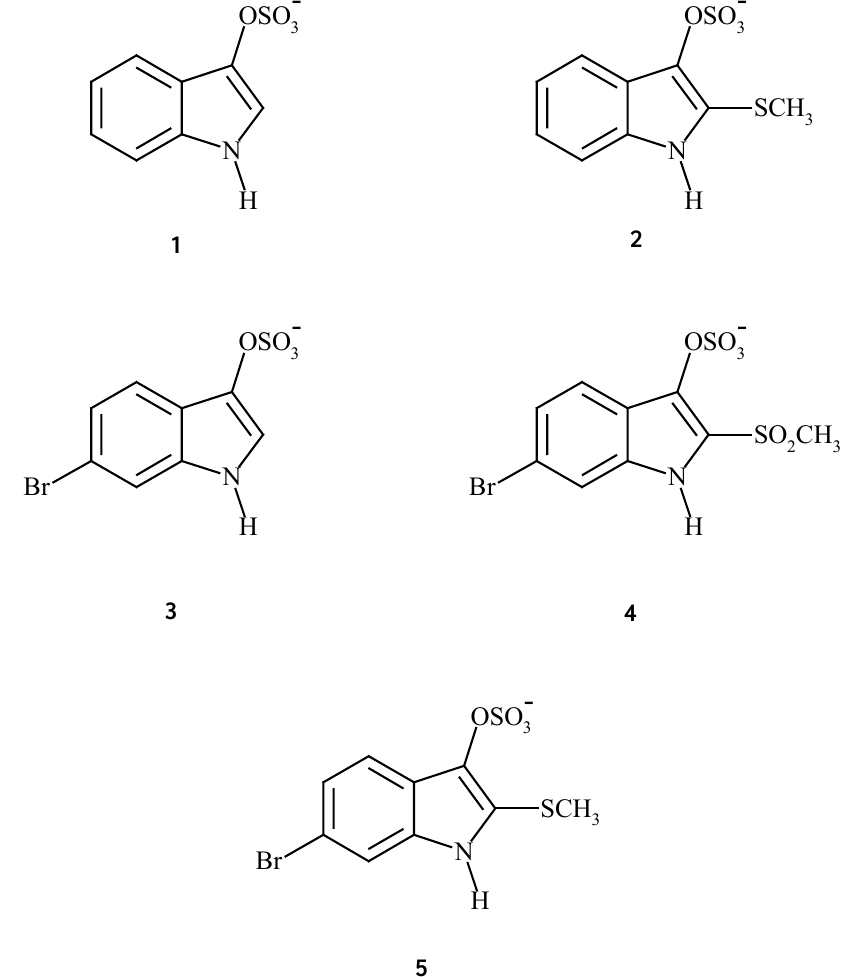
Figure 9. Precursors to the purple colour in